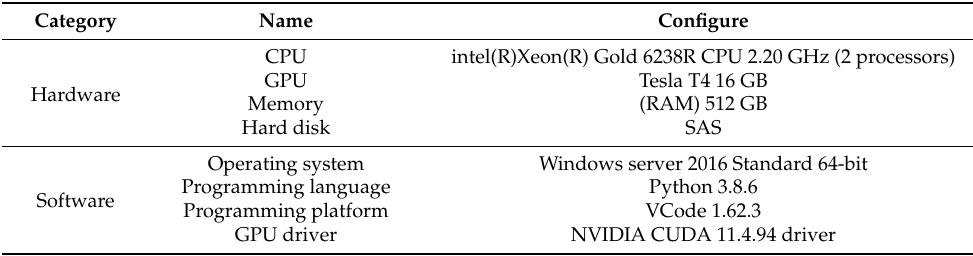
Table 1. Experimental environment configuration.